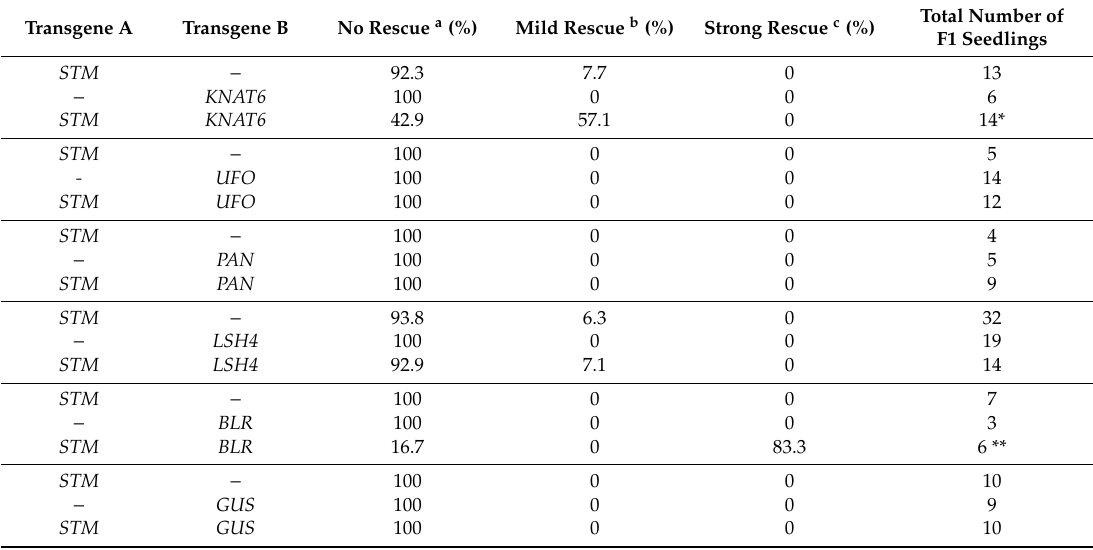
Table 3. E ff ect of combined expression of STM and other downstream genes on the phenotype of cuc1 cuc2 . Transgene